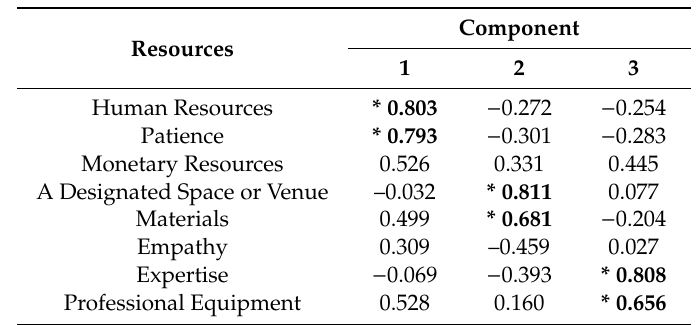
Table 5. Component